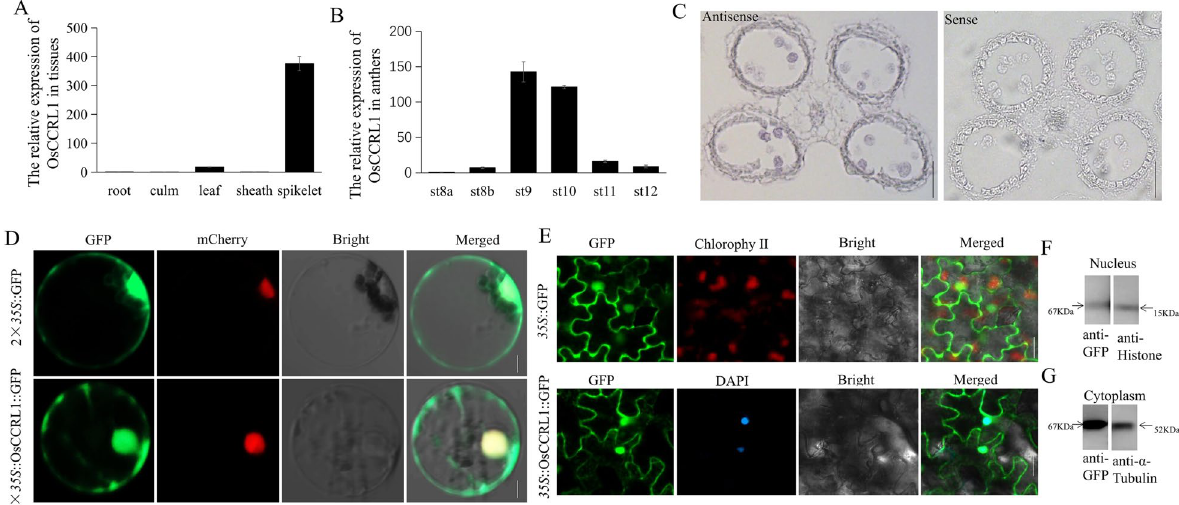
Fig. 4 Expression analysis and subcellular localization of OsCCRL1 . A , B Abundance of OsCCRL1 transcripts in wild-type different tissues and anthers at different developmental stages. Data are means SD ( n 3). C mRNA in situ hybridization of OsCCRL1 transcripts in the wild-type anther. Scale ± = bars, 50 μm. D Subcellular localization of 2 35S ::GFP and 2 35S ::OsCCRL1 - GFP in rice protoplasts. OsH2B-mCherry was used to indicate the × × nucleus. Scale bars, 5 μm. E Subcellular localization of 35S ::GFP and 35S ::OsCCRL1-GFP with DAPI in Nicotiana benthamiana. Scale bar: 5 μm. F Immunoblotting of extracted nuclear proteins from tobacco leaves expressing OsCCRL1-GFP using anti-GFP antibodies and Histone antibodies. Histone antibodies was used as the internal reference antibody. G Immunoblotting of extracted cytoplasm proteins from tobacco leaves expressing OsCCRL1-GFP using anti-GFP antibodies and Tubulin antibodies. Tubulin antibodies was used as the internal reference